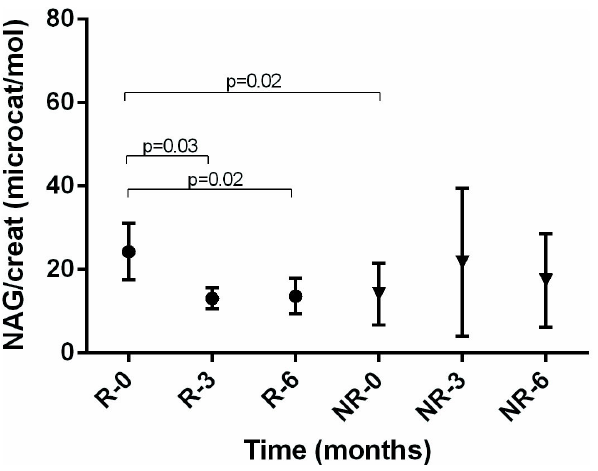
Figure 3. Mean of NAG to creatinine ratio in responders (R) and non-responders (NR) in time.